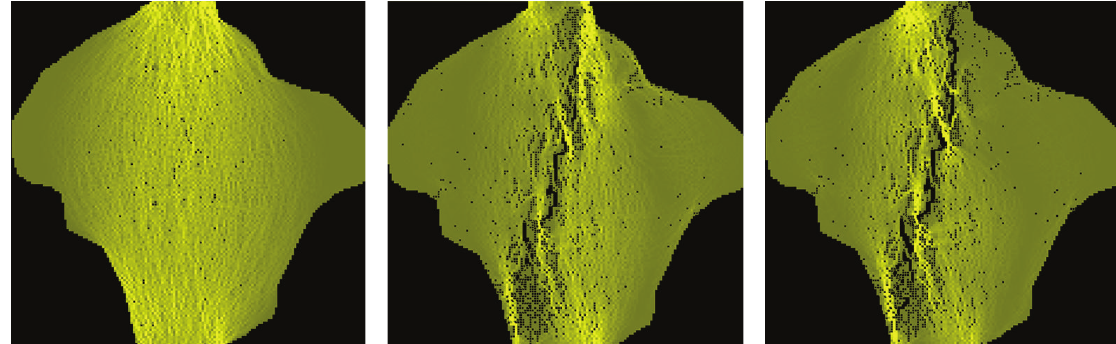
Figure 4: Maximum shear stress distribution map under static loading condition ((a)–(c) denote the order of rupture, and the stress unit is MPa).